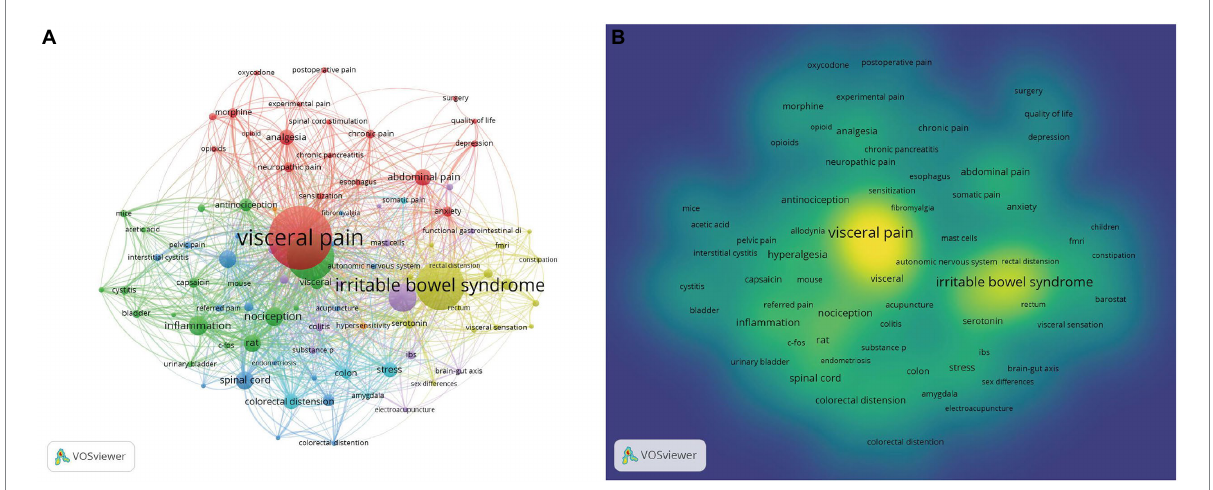
FIGURE 7 (A) The co-occurrence map of keywords in visceral pain research ( T ≥ 20) Notes: The size of node reflects the keyword’s co-occurrence frequencies, the link indicates the co-occurrence relationship between keywords, and the same color of node represent the same cluster. (B) The density map of keywords in visceral pain research ( T ≥ 10). The size of word, the size of round, and the opacity of yellow is positively related to the co-occurrence